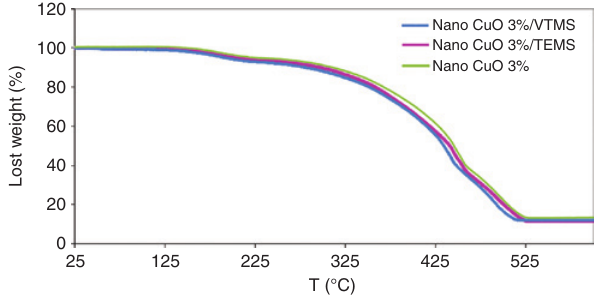
Figure 9: Comparison of TGA graph of epoxy acrylate containing 3% w/w nano CuO, nano CuO + TEMS, and nano CuO +